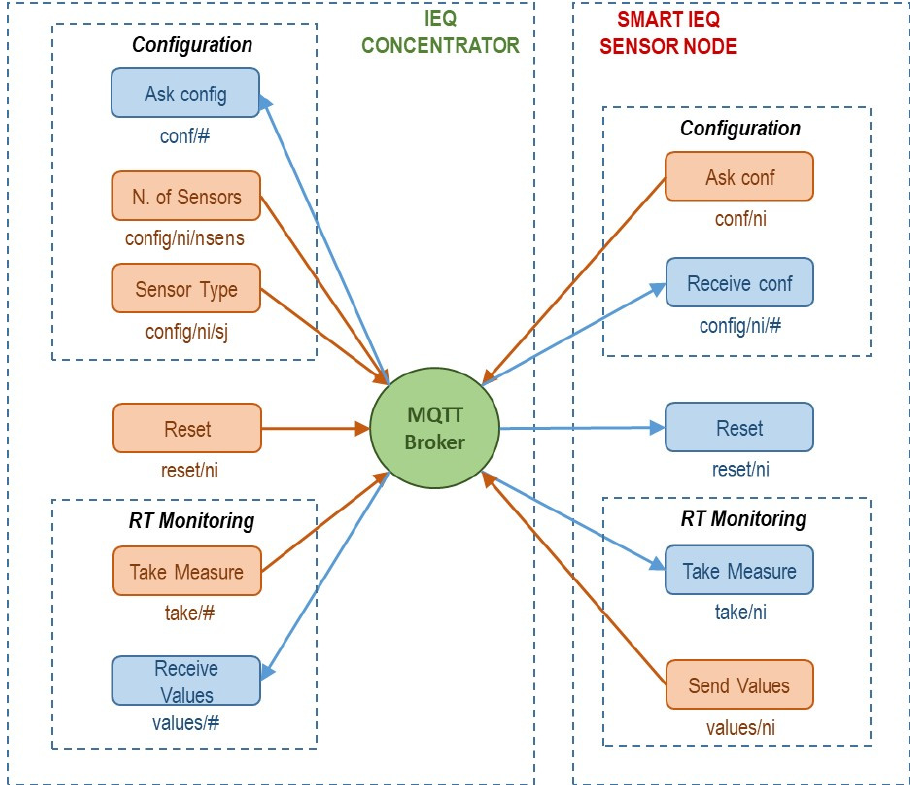
Figure 2. MQTT topics used for connecting IEQ concentrators with smart IEQ sensor nodes. The numbers i = 1, 2, 3… represent the node identifier; the number j = 1, 2, 3… represent the sensors attached to the nodes. Finally, the symbol # means being subscribed to all subtopics. Published topics are in the orange color, whereas subscribed topics are in the blue color.